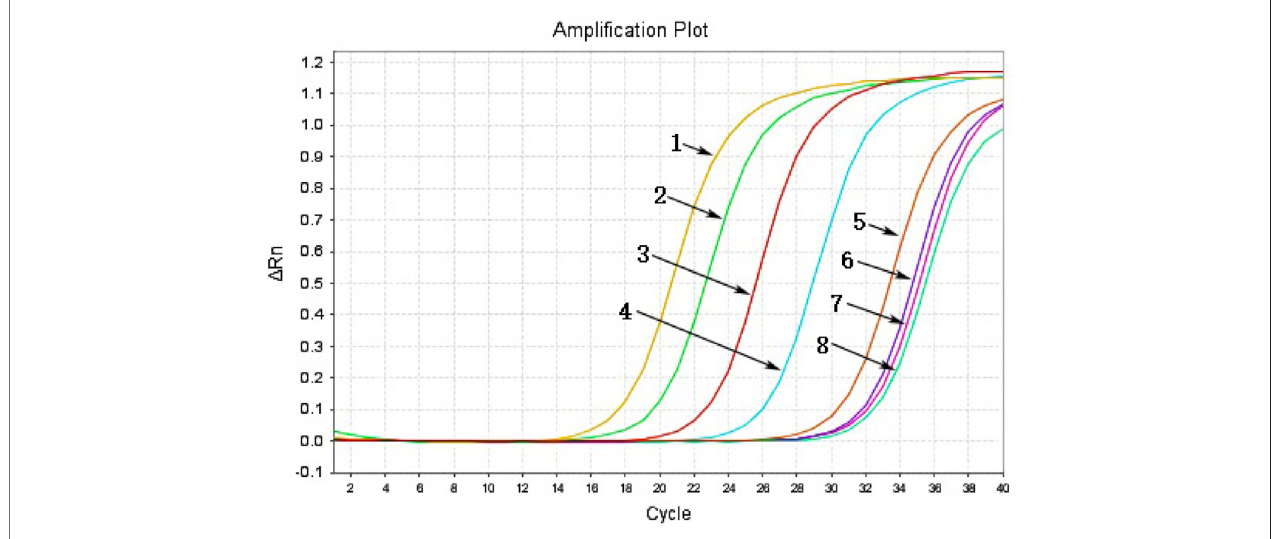
FIGURE6| TheproductsofaserialdilutionofHBVplasmidDNAmeasuredinqPCR.1,productof100-pgtemplate;2,productof10-pgtemplate;3,productof1- pg template; 4, product of 100-fg template; 5, product of 10-fg template; 6, product of 1-fg template; 7, product of 0.1-fg template; 8, product of water template.